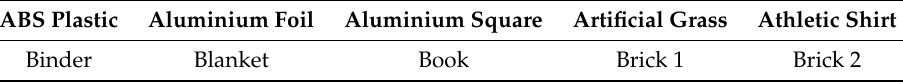
Table 1. Textures from the Penn Haptix Toolkit chosen for experiments.